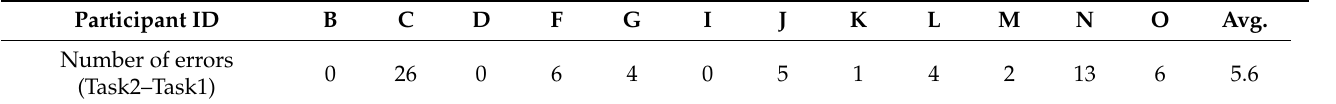
Table 7. Difference in the number of errors between Task1 and